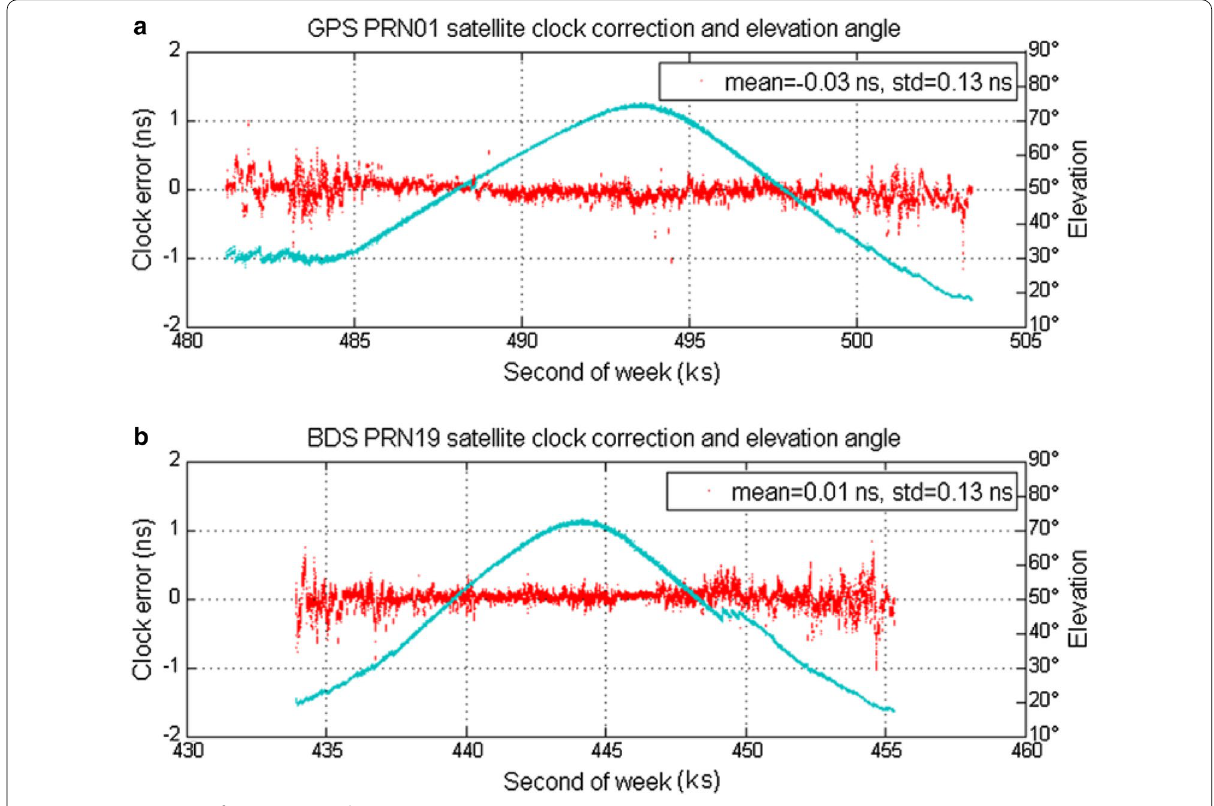
Fig. 4 Fast corrections of GPS PRN01 and BDS PRN19